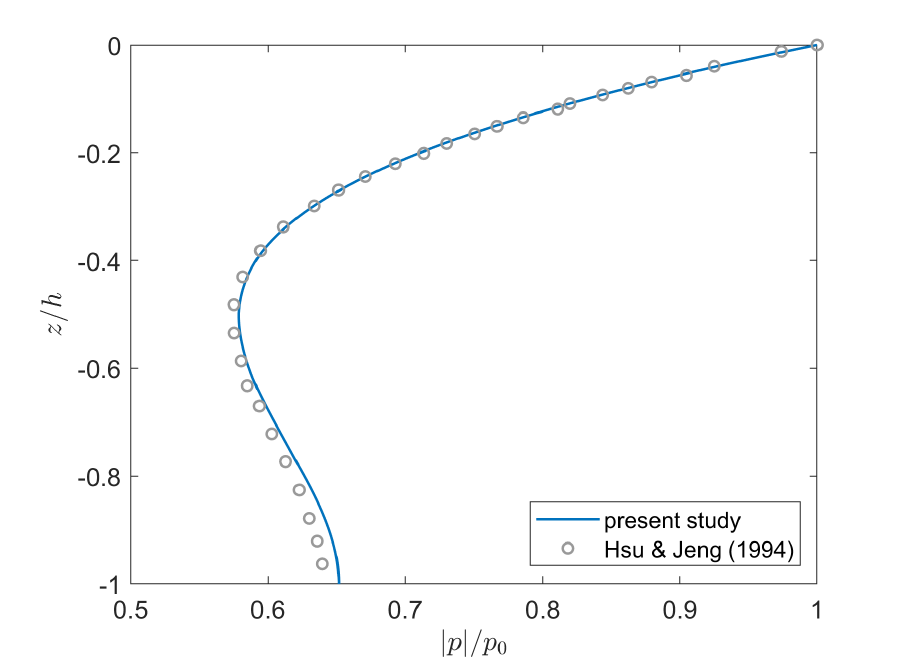
Figure 3. Amplitude profile of pore pressure p for the horizontal transverse isotropic